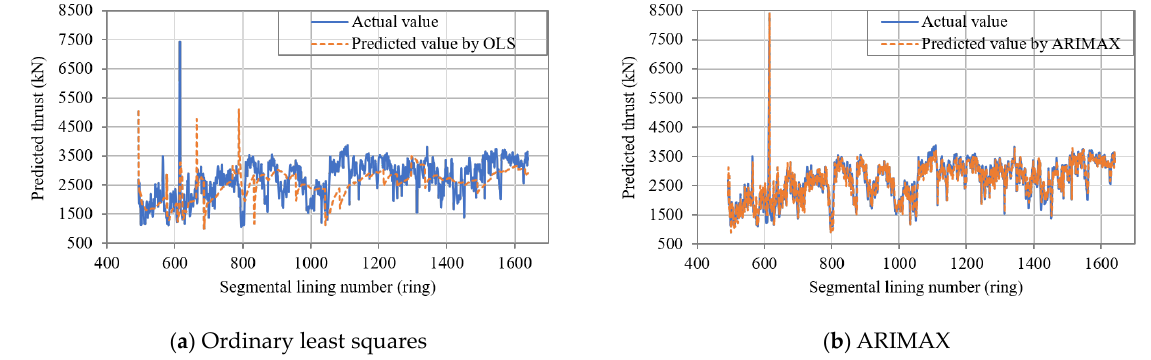
Figure 4. Prediction results of current thrust in project A-1.